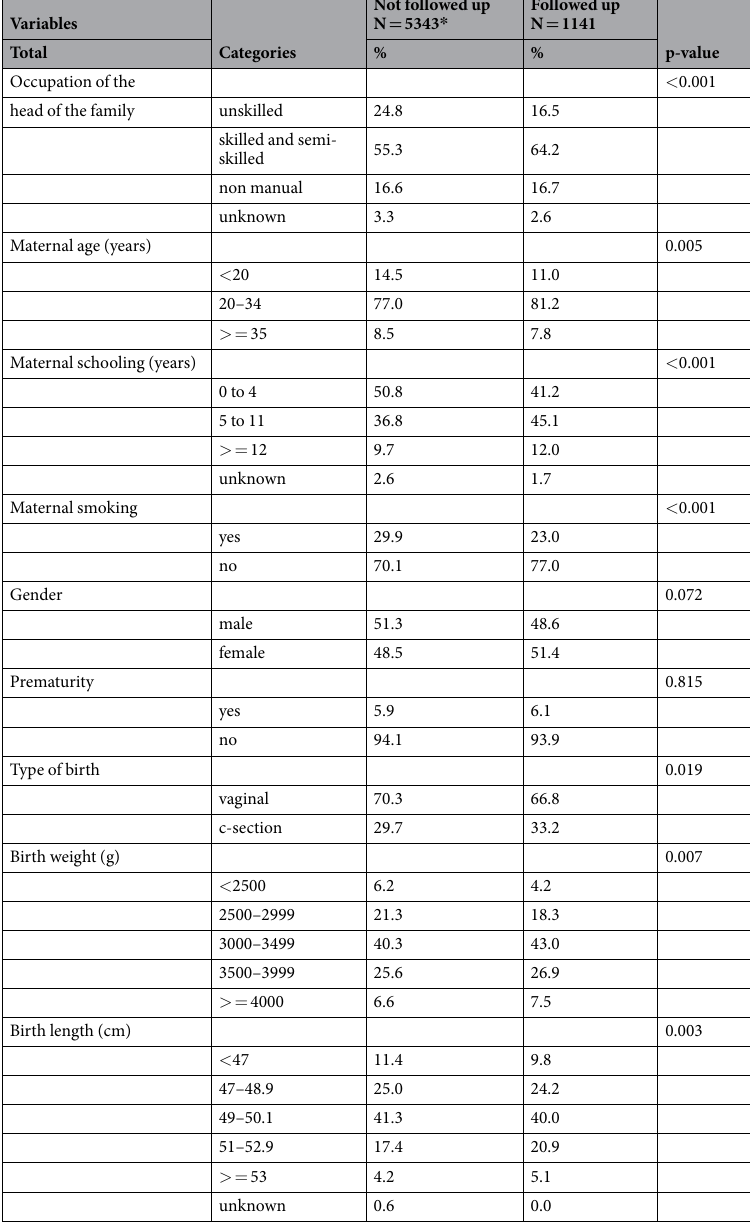
Table 1. Comparison of the characteristics at birth of non followed up subjects with those followed up until adulthood (2002/2004). * 343 deaths